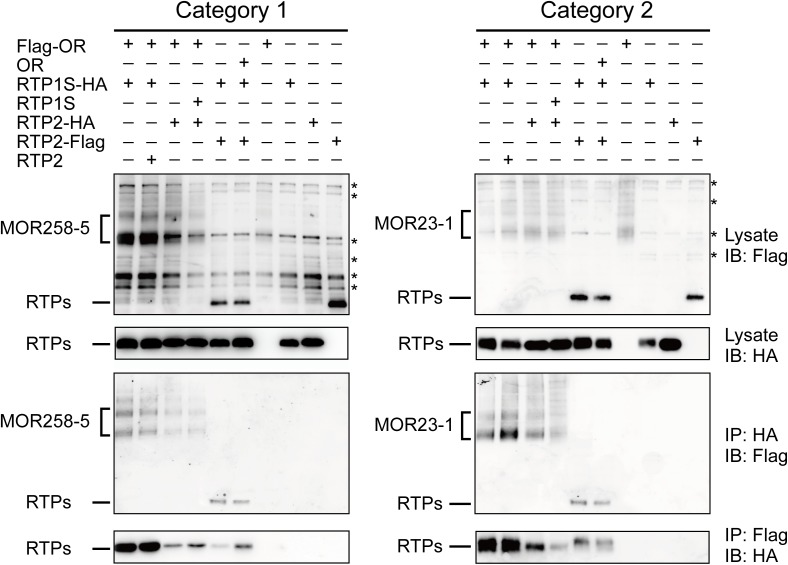
OR, RTP1S, and RTP2 interact with each other in HEK293T cells.Left, interactions among MOR258-5 (Category 1), RTP1S and RTP2. Right, interactions among MOR23-1 (Category 2), RTP1S and RTP2. First and second panels, protein lysates of HEK293T cells transfected with Flag-tagged OR and/or HA-tagged RTP1S and Flag-tagged/HA-tagged RTP2 and blotted with anti-Flag or anti-HA antibody. Third panels, co-immunoprecipitation of Flag-tagged proteins with anti-HA antibody. Fourth panels, co-immunoprecipitation of HA-tagged proteins with anti-Flag antibody. Refer to S4 Fig for the original blots. IB, immunoblot; IP, immunoprecipitation. The asterisks indicate non-specific bands.